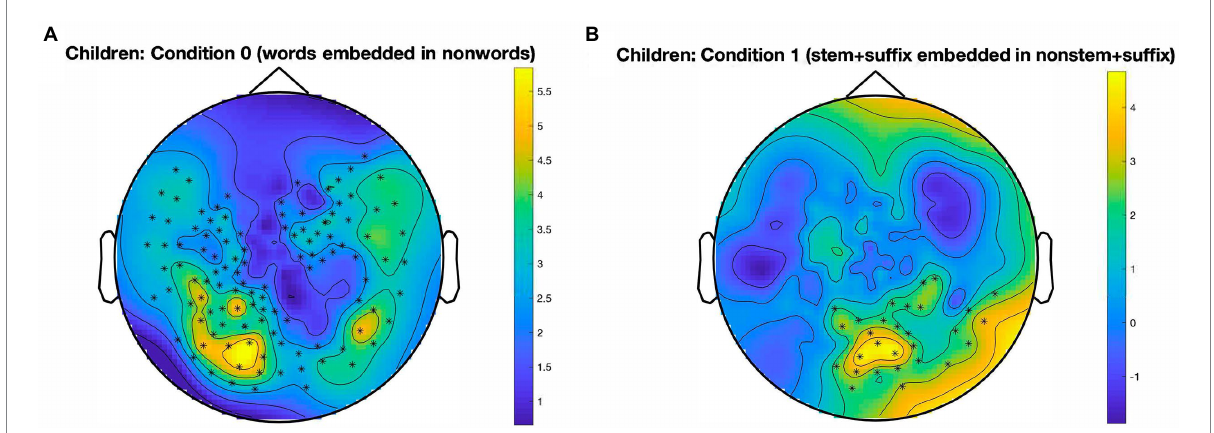
FIGURE 3 Clusters in which a significant oddball response emerged, by condition. Data from developing readers. (A) : Temporo-parieto-occipital cluster, largely left-lateralized, for the identification of words in nonwords, in Condition 0; p < 0.001, cluster alpha level = 0.05. (B) : Central occipital cluster for the identification of stem + suffix oddballs in nonstem + suffix base stimuli, in Condition 1; p = 0.007, cluster alpha level = 0.05. Color bars represent SNR on a continuous scale (blue = low, yellow = high). Condition 0: words in nonwords ( roll in kltq ); Condition 1: stem + suffix in nonstem + suffix ( softity in terpity